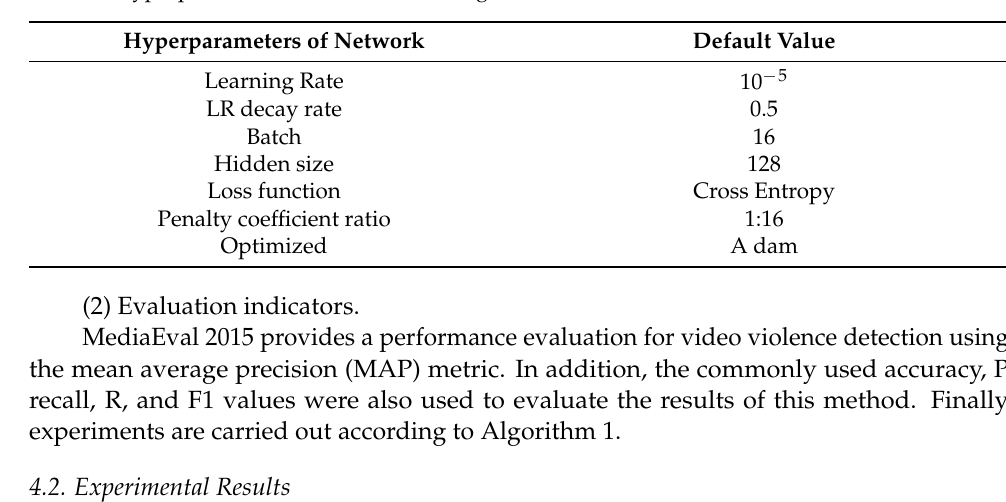
Table 3. Hyperparameters of network training.